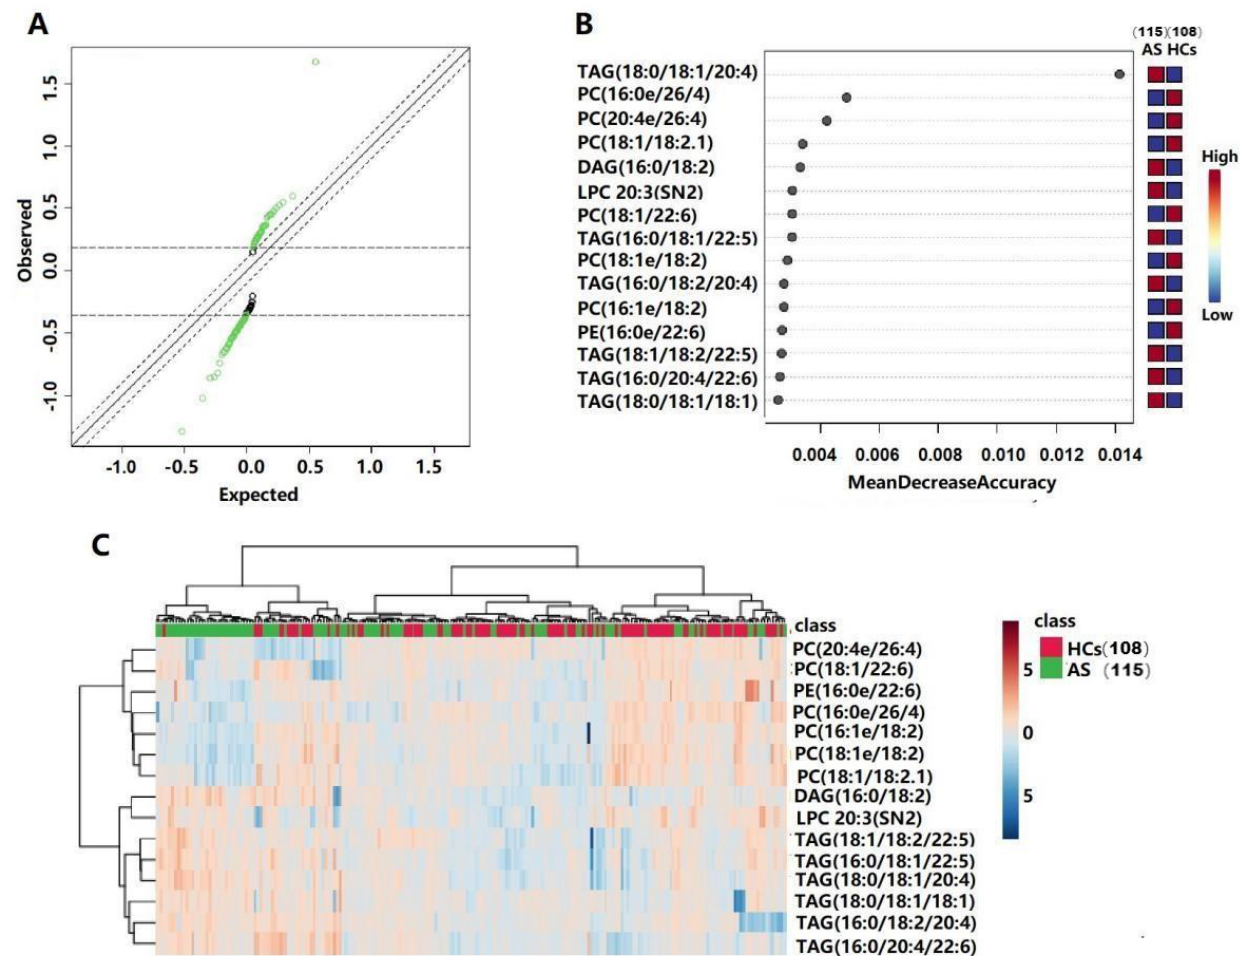
Figure 2. Identification of potential lipid biomarkers for the diagnosis of AS. ( A ) Orthogonal partial least squares discriminant analysis (OPLS-DA) score plot based on HC and AS groups in the dis- covery set. ( B ) Results of 200 permutation tests of the OPLS-DA model.